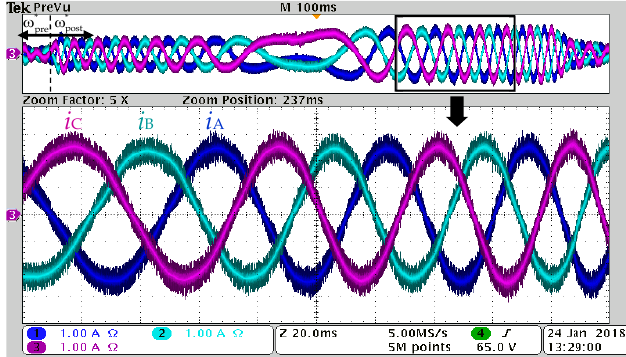
Figure 8. Experimental results of phase currents i A , i B , and i C , under a change of the rotation direction. Conditions: ω * pre = 350 rpm, ω * post = −350 rpm (remaining conditions are the same as in Figure 7).